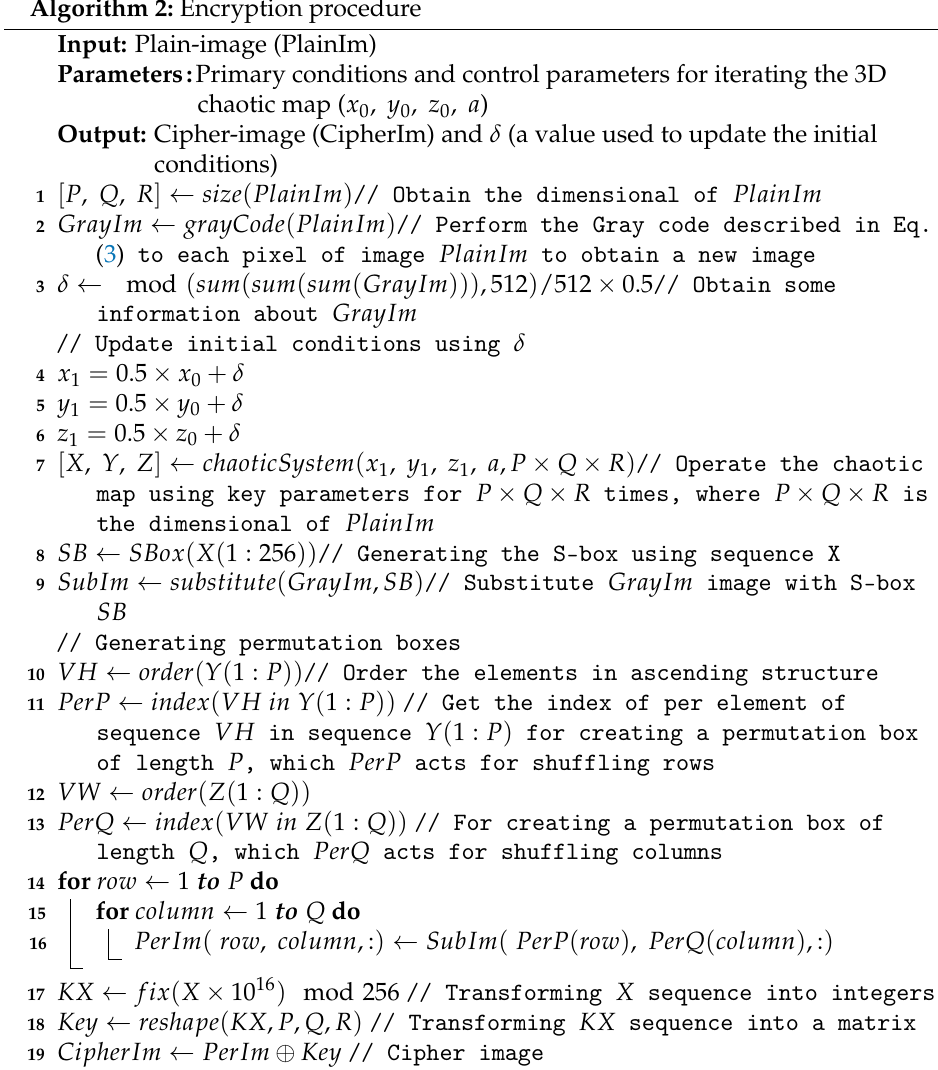
Algorithm 2: Encryption